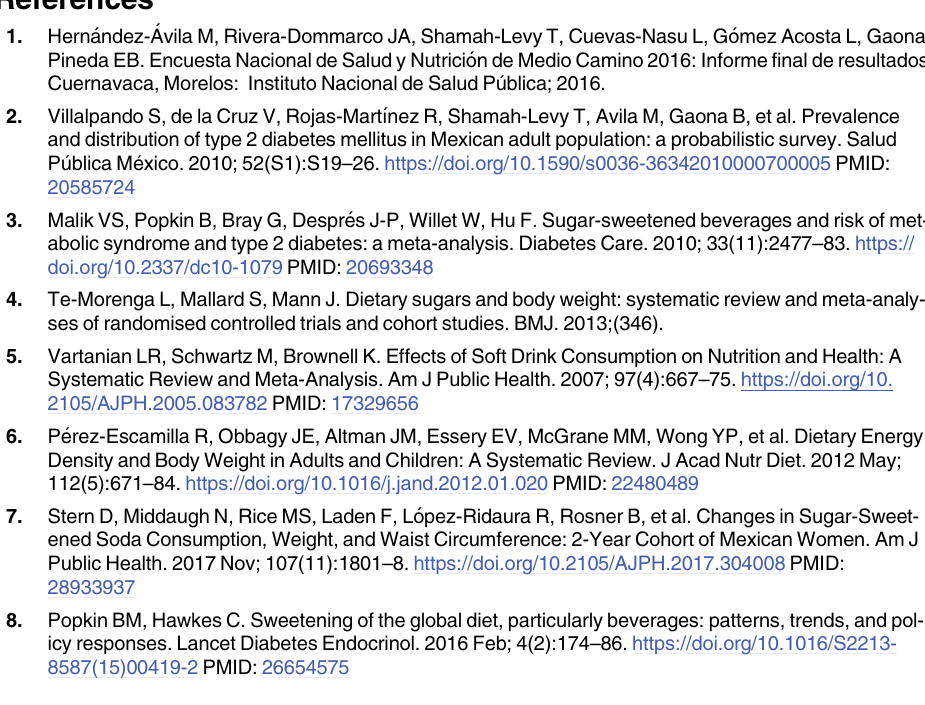
S1 Fig. Example of responses in the bidding process for a sequence of questions when the random start value is 100